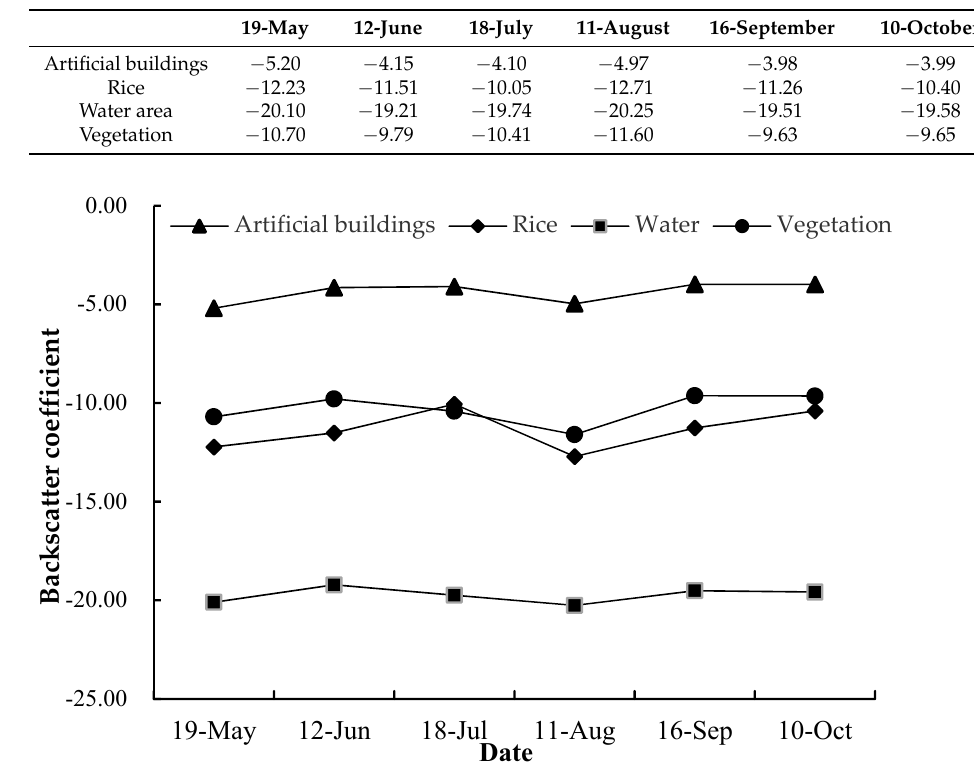
Figure 15. VV polarization backscatter coefficient of ground objects.